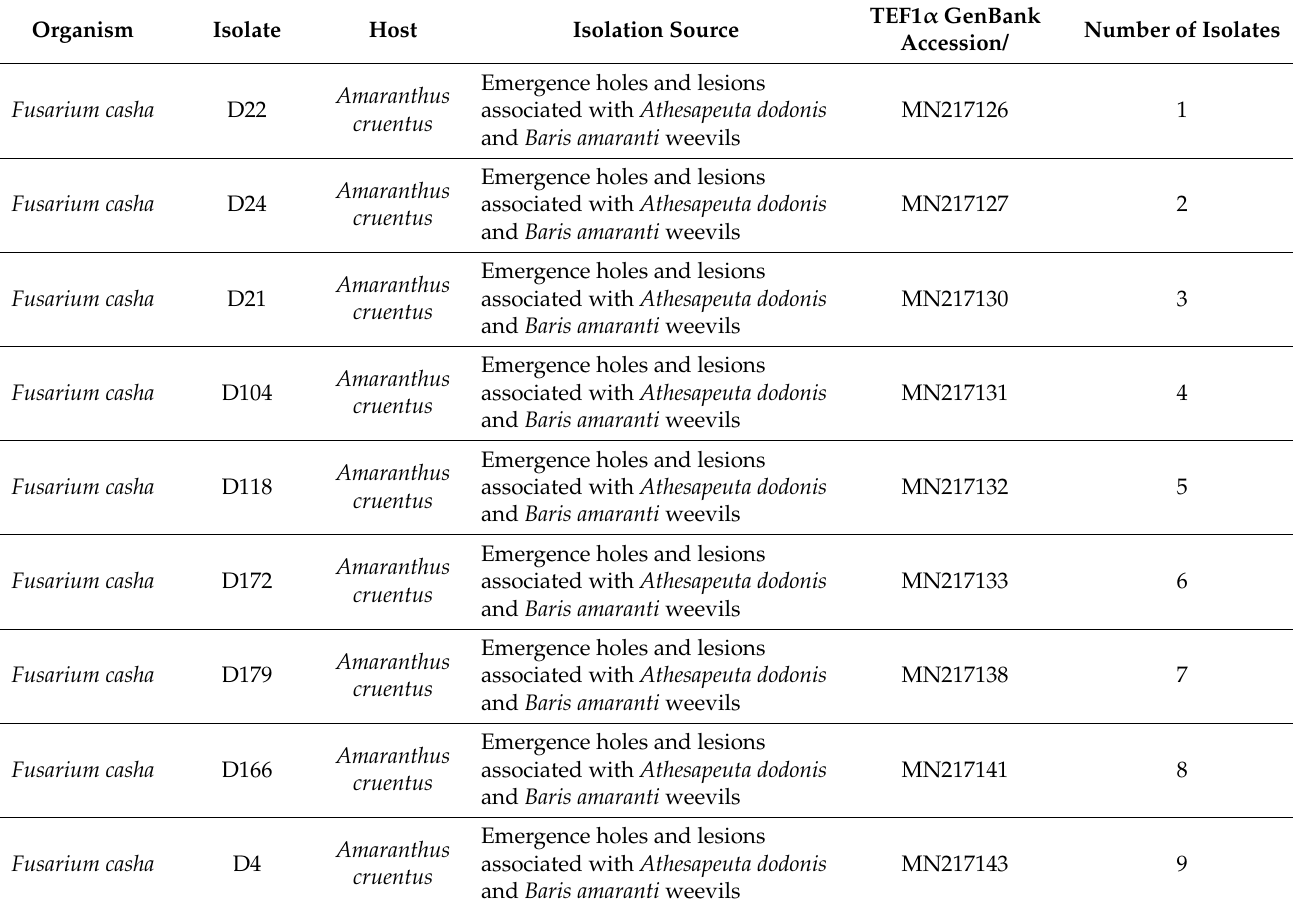
Table A1. Isolates identified based on translation elongation factor 1 α (TEF1 α